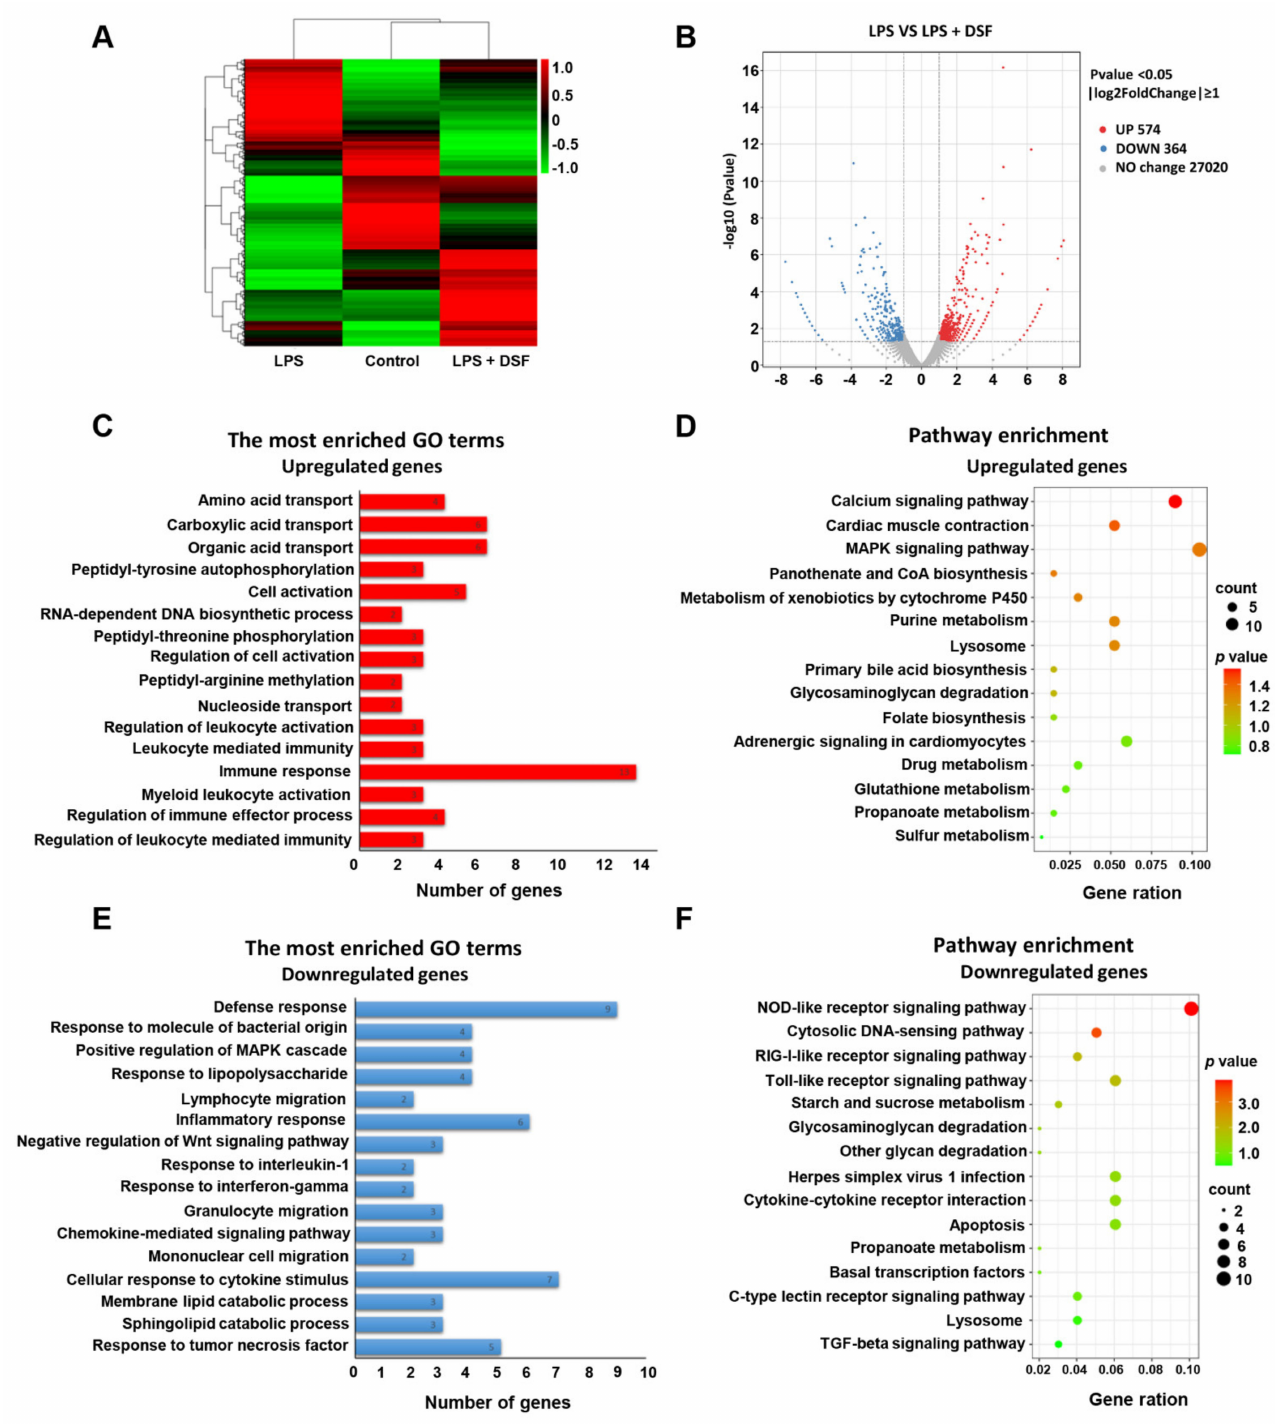
Figure 6. Transcriptome analysis of differentially expressed genes between LPS and LPS + DSF groups. ( A ) Heat map representation showing a total of 2029 DGEs in control, LPS- and LPS + DSF-treated zebrafish embryos. ( B ) Volcano plots show a total of 938 DGEs in LPS and LPS + DSF groups. ( C ) GO term analysis and ( D ) KEGG pathway analysis for up-regulating DEGs in LPS + DSF zebrafish embryos compared to the LPS group. ( E ) GO term analysis and ( F ) KEGG pathway analysis of down-regulated DEGs in LPS + DSF zebrafish embryos compared to the LPS group. The size of the dot indicates the number of genes enriched in an individual item. The color of the dot represents the p